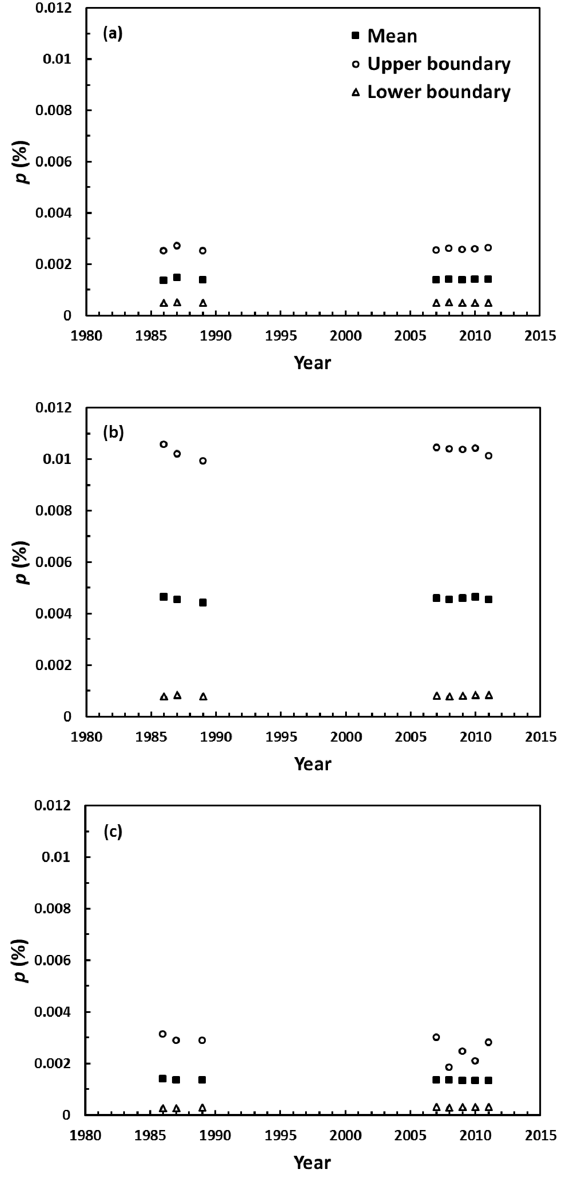
Figure 8. Temporal changes of p ‐ values over the 1986 to 2012 period. ( a ) Dashui; ( b ) Zoige; and ( c ) Baihe. Data labeled upper boundary represent the possible high p ‐ values in the same year, while data labeled lower boundary represent the possible low p ‐ values in the same year.